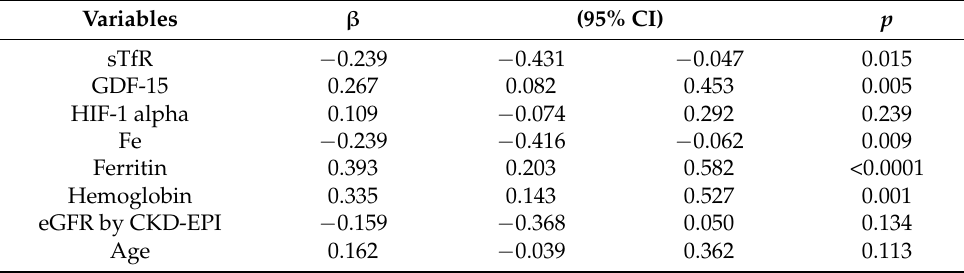
Table 4. Results of linear regression analyses for serum hepcidin